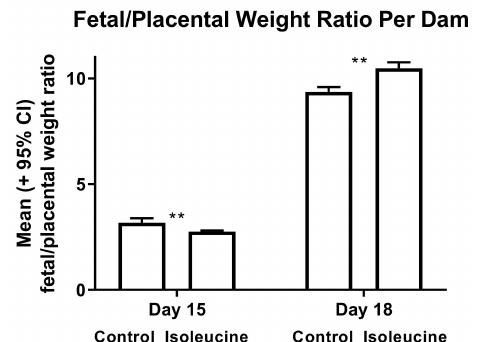
Figure 4. The fetal / placental weight ratio on a per dam basis was larger in the control than in the experimental (isoleucine) mice on day 15 (t-test, p < 0.001), but this ratio was larger in the experimental than in the control mice on day 18 (t-test, p < 0.0001). Double asterisks (**) indicate mean values that are significantly di ff erent from each other (control day 15, n = 8 dams and day 18, n = 9 dams; isoleucine day 15, n = 10 dams and day 18, n = 12 dams).